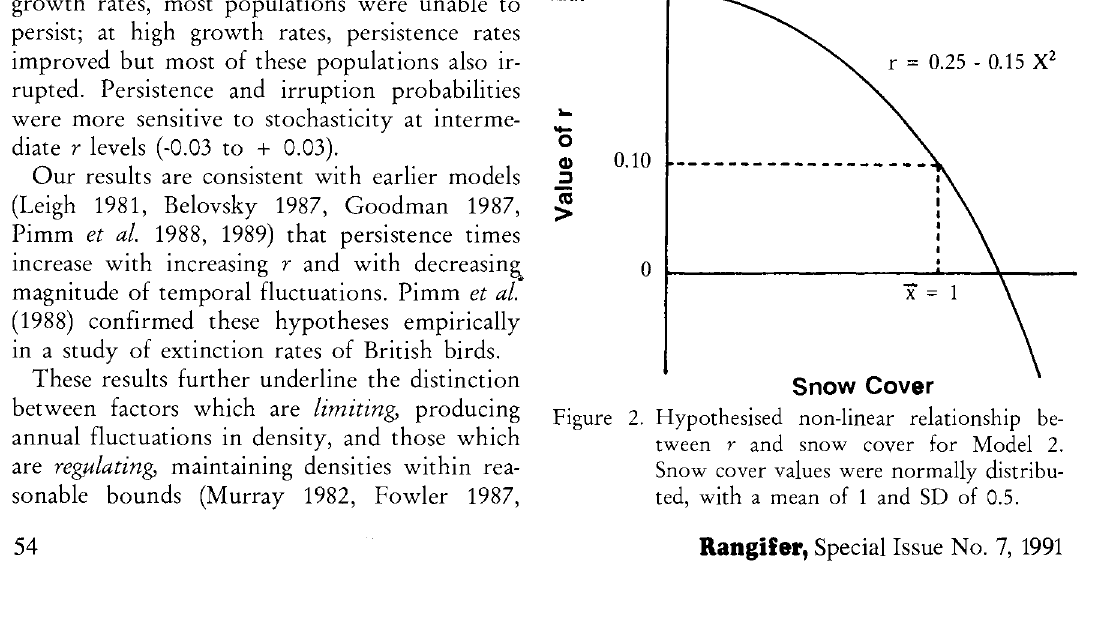
Figure 1. Probabilities (%) of (A) persistence (N > 1) and (B) irruption (N > 1000) under various combinations of r and stochastici- ty. Each datum represents 1000 replicate populations projected over 1000 years ( N 0 = 50) specific to each combination of mean r value and SD. The full model was N t + ] = N t e r where N represented popula tion size, and r was a normally-distributed growth rate with a mean varying from - 0.10 to + 0.10 and a SD varying from 0 to 0.5 of r M AX (0.25).